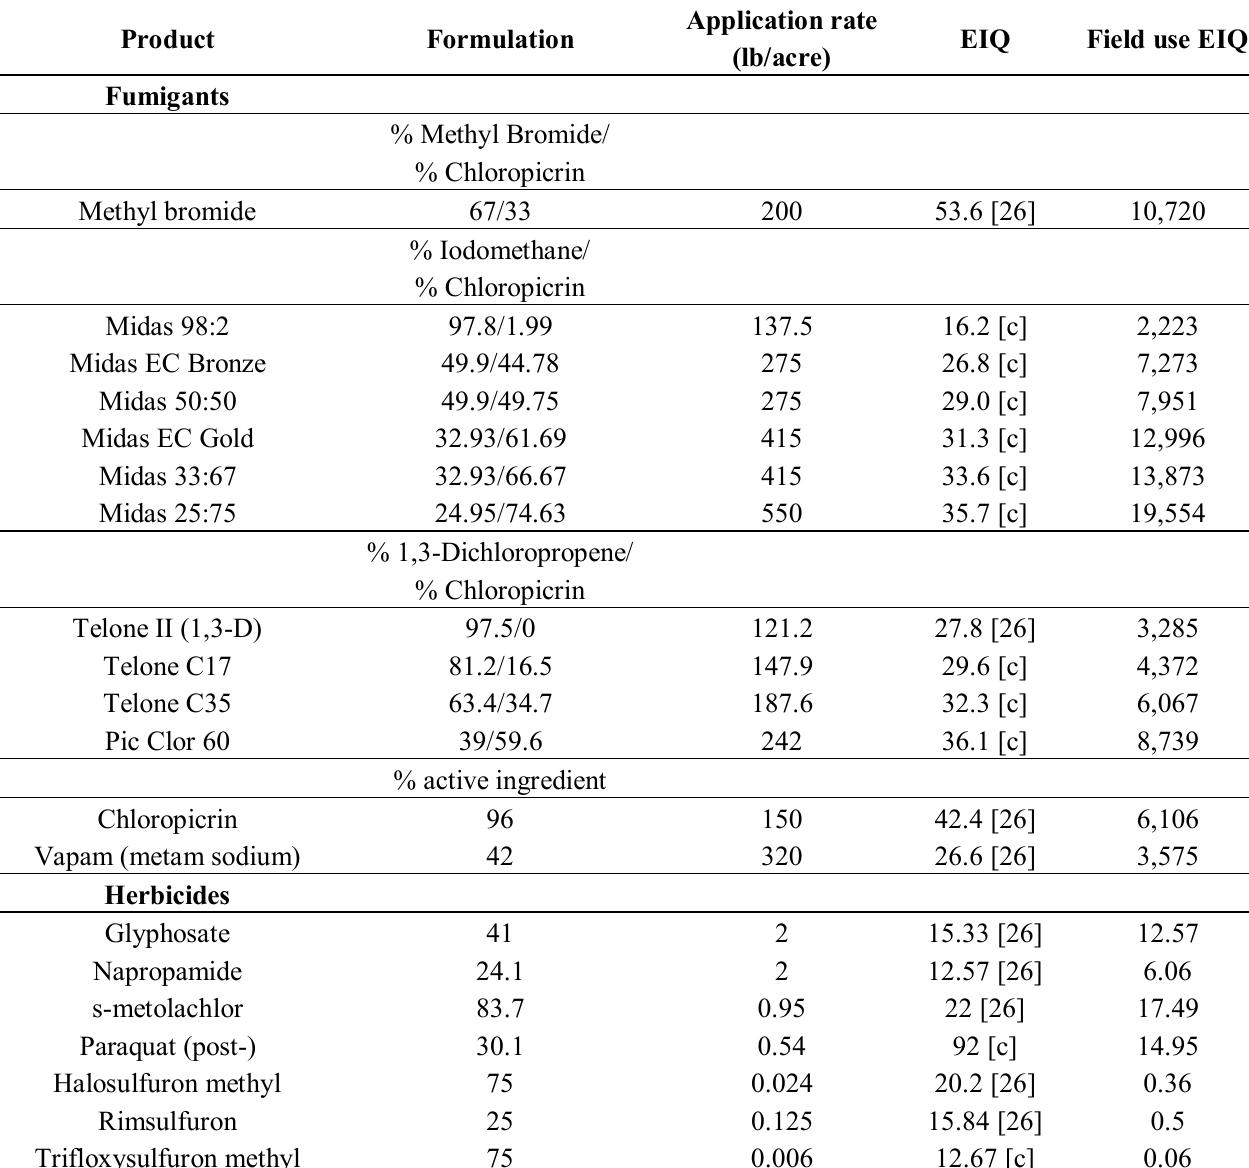
Table 6. Fumigant and herbicide